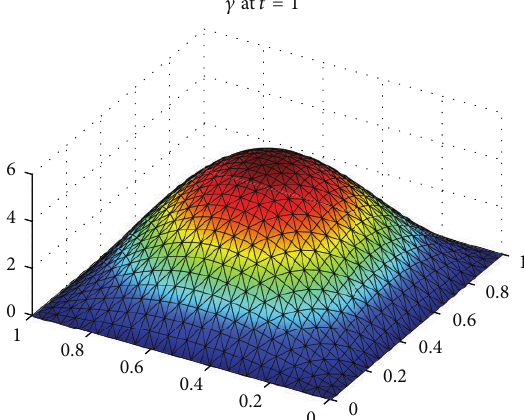
Figure 7: Surface for exact solution 𝛾 .